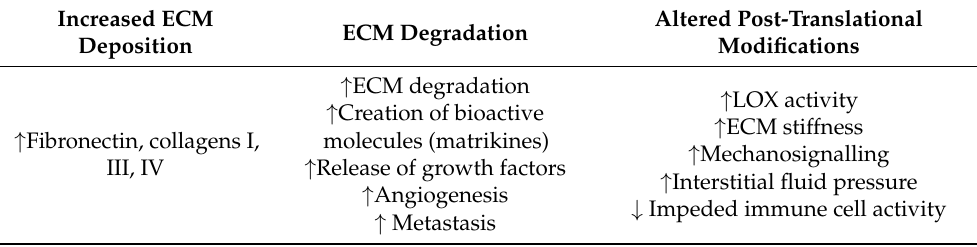
Table 1. Main ECM remodelling processes in cancer in respect to normal